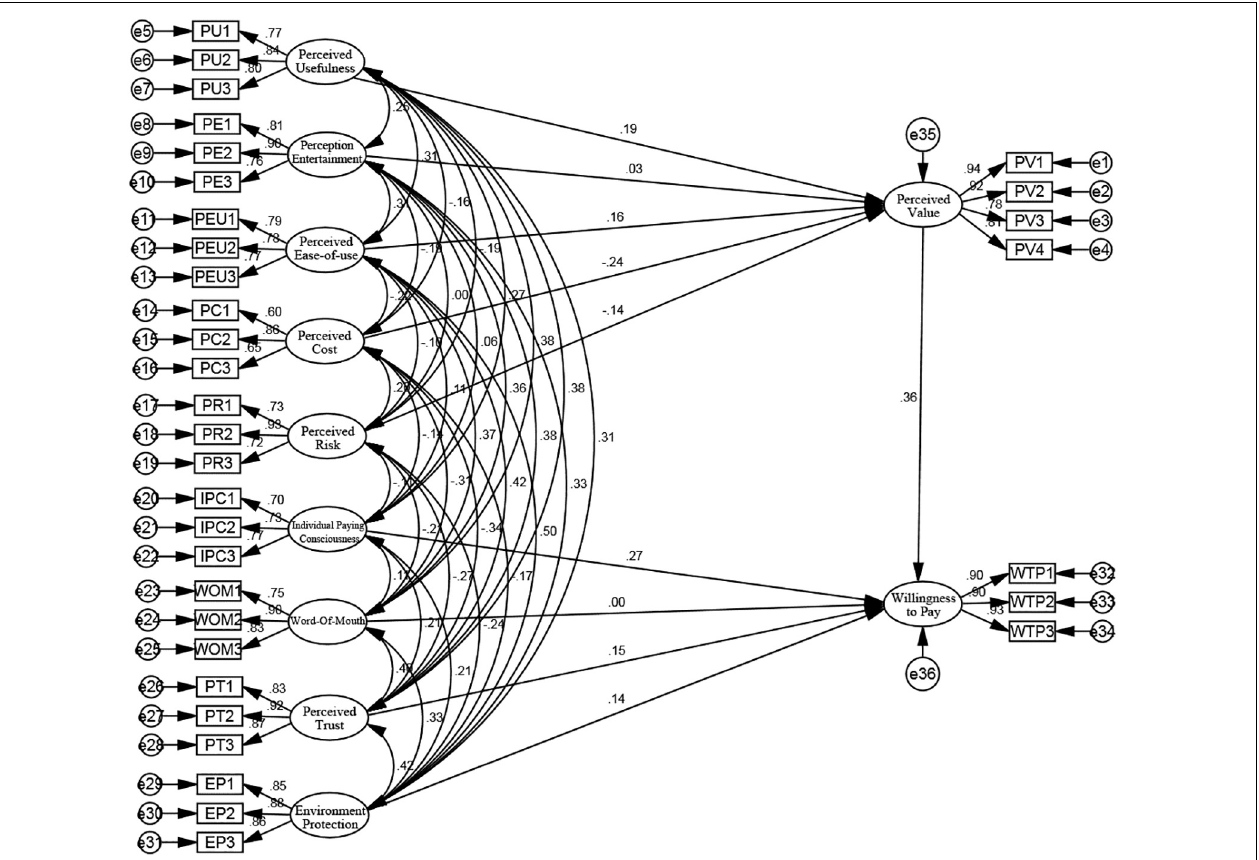
FIGURE 3 | Structural equation analysis